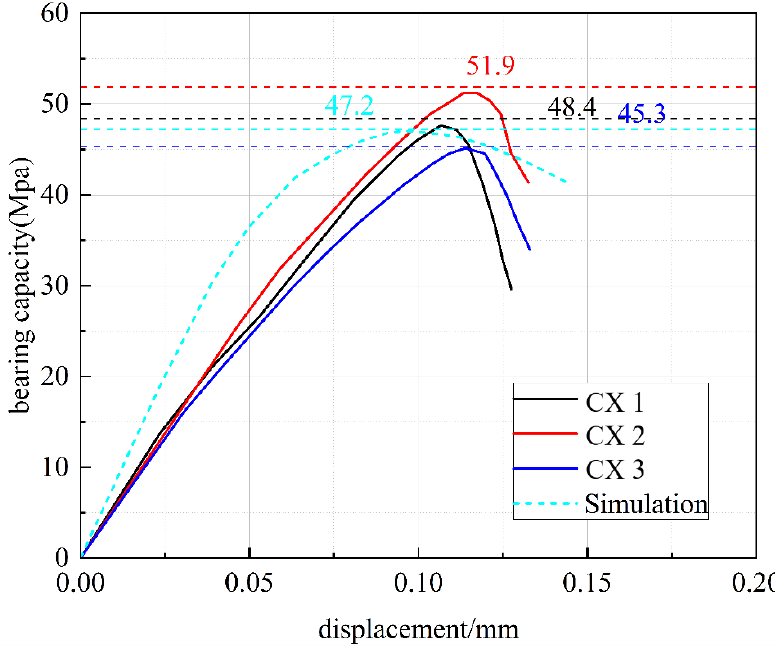
Figure 17. Load–displacement curves associated with the X-axis compression test and correspond- ing numerical simulation.